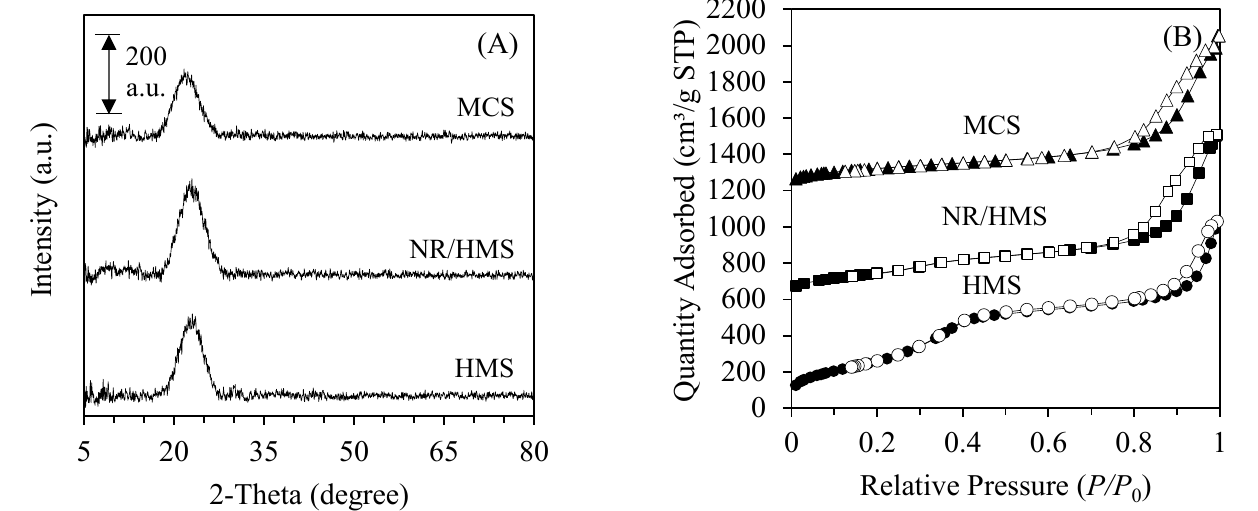
Figure 1. ( A ) XRD patterns and ( B ) N 2 physisorption isotherms of HMS, NR/HMS, and MCS. The XRD patterns of the Nb/HMS and Nb/MCS with different Nb loading amounts are shown in Figure 2A,B, respectively. The characteristic peaks of Nb 2 O 5 were not ob- served for both 10-Nb/HMS and 10-Nb/MCS, indicating the small crystallites of Nb 2 O 5 well dispersed on the HMS and MCS surface. An increase in the amount of Nb loaded on the HMS and MCS surface to 20 and 30 wt.% enhanced the characteristic peaks of Nb 2 O 5 at 2 θ = 22.6°, 28.5°, 36.7°, 46.2°, 50.5°, 55.2°, 64.2° and 70.8° [29], which indicate the enlarged